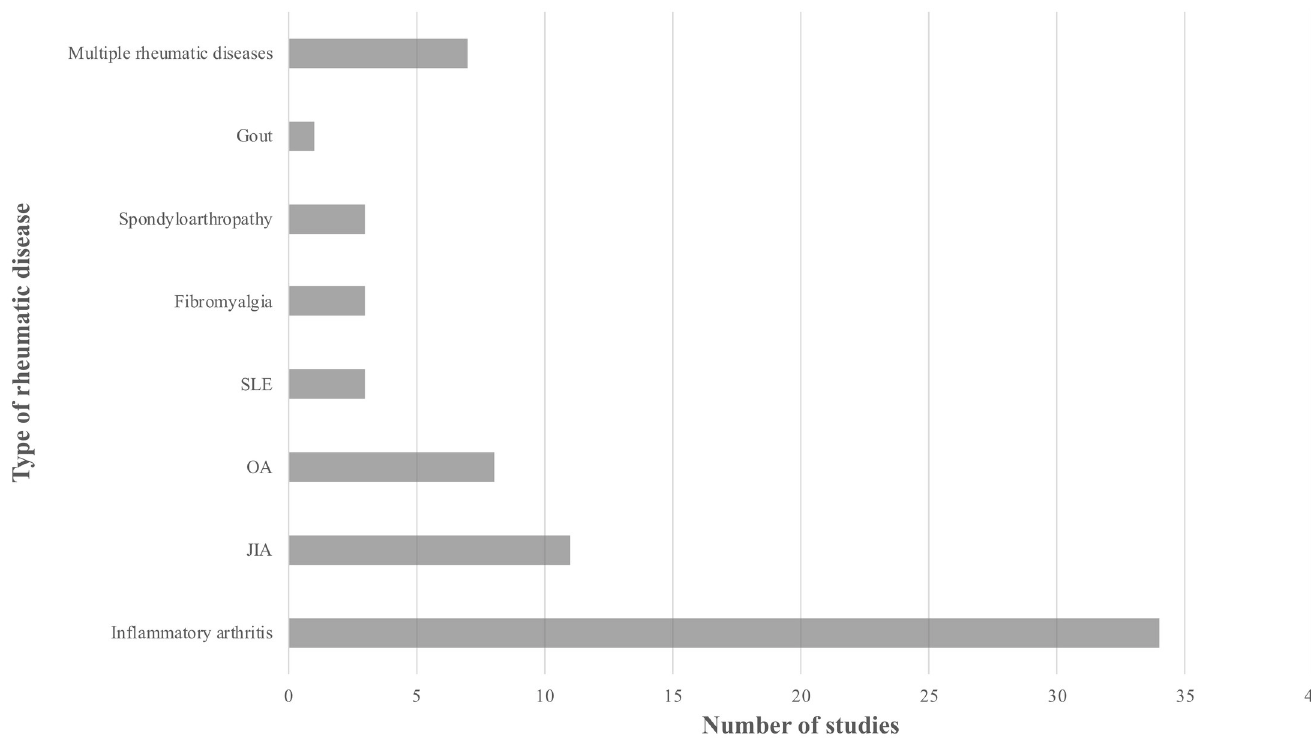
Fig 3. Types of rheumatic disease